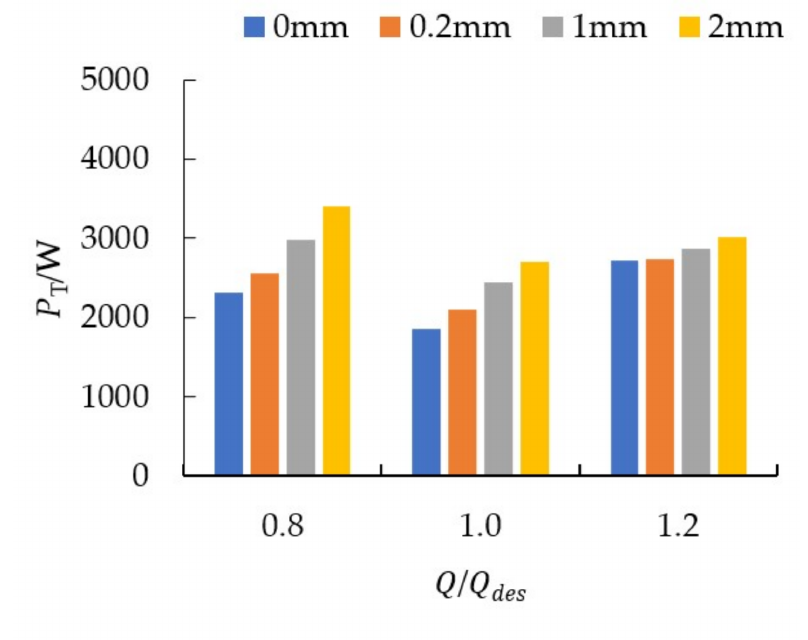
Figure 7. Influence of tip clearance on total dissipation under pump